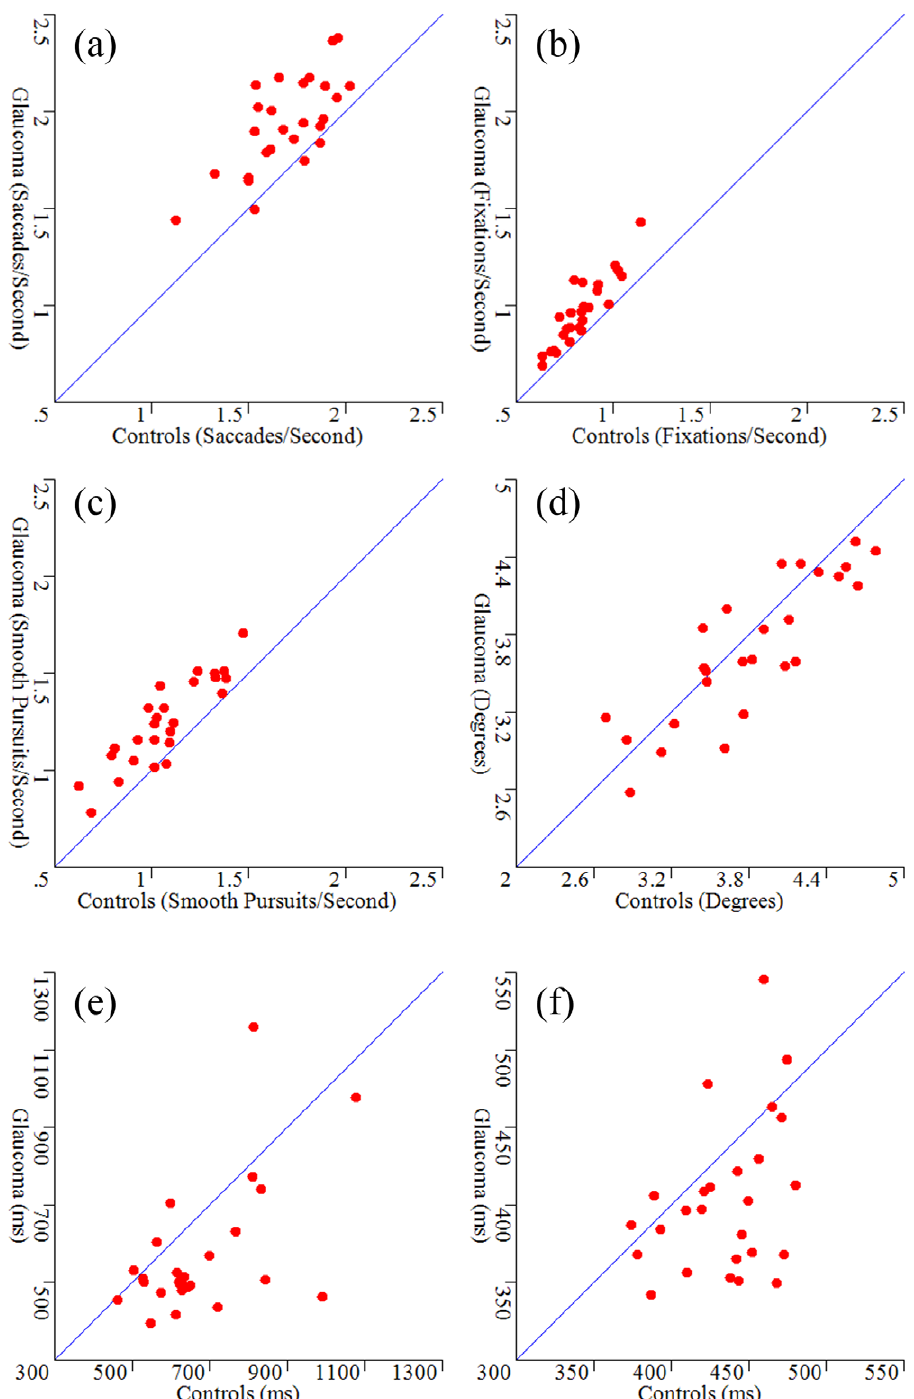
Figure 1. Eye movements for patients and controls. Graphs showing the average response in each eye movement parameter for the patients and the controls with (a) average number of saccades per second; (b) average number fixations per second; (c) number of smooth pursuits per second of film; (d) average saccade amplitude (size in degrees); (e) average fixation duration (ms); and (f) average ‘smooth pursuit’ duration (ms). Each symbol represents the results from one of the 26 films. If there were no differences in the averages then symbols would fall exactly on the line of unity. For example, (a) indicates that the patients made, on average, more saccades across the films than the control subjects, which illustrates the statistically significant effect found in the GLM ANOVA.